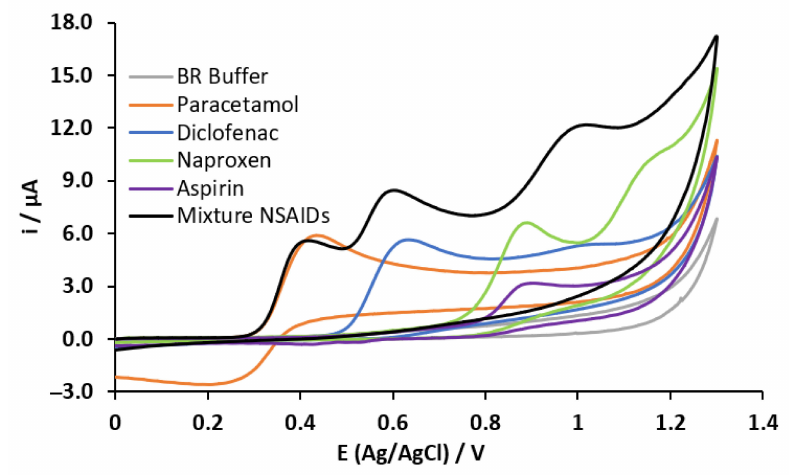
Figure 7. CVs for each NSAID under study: a mixture containing the four NSAIDs and the supporting electrolyte (BR).